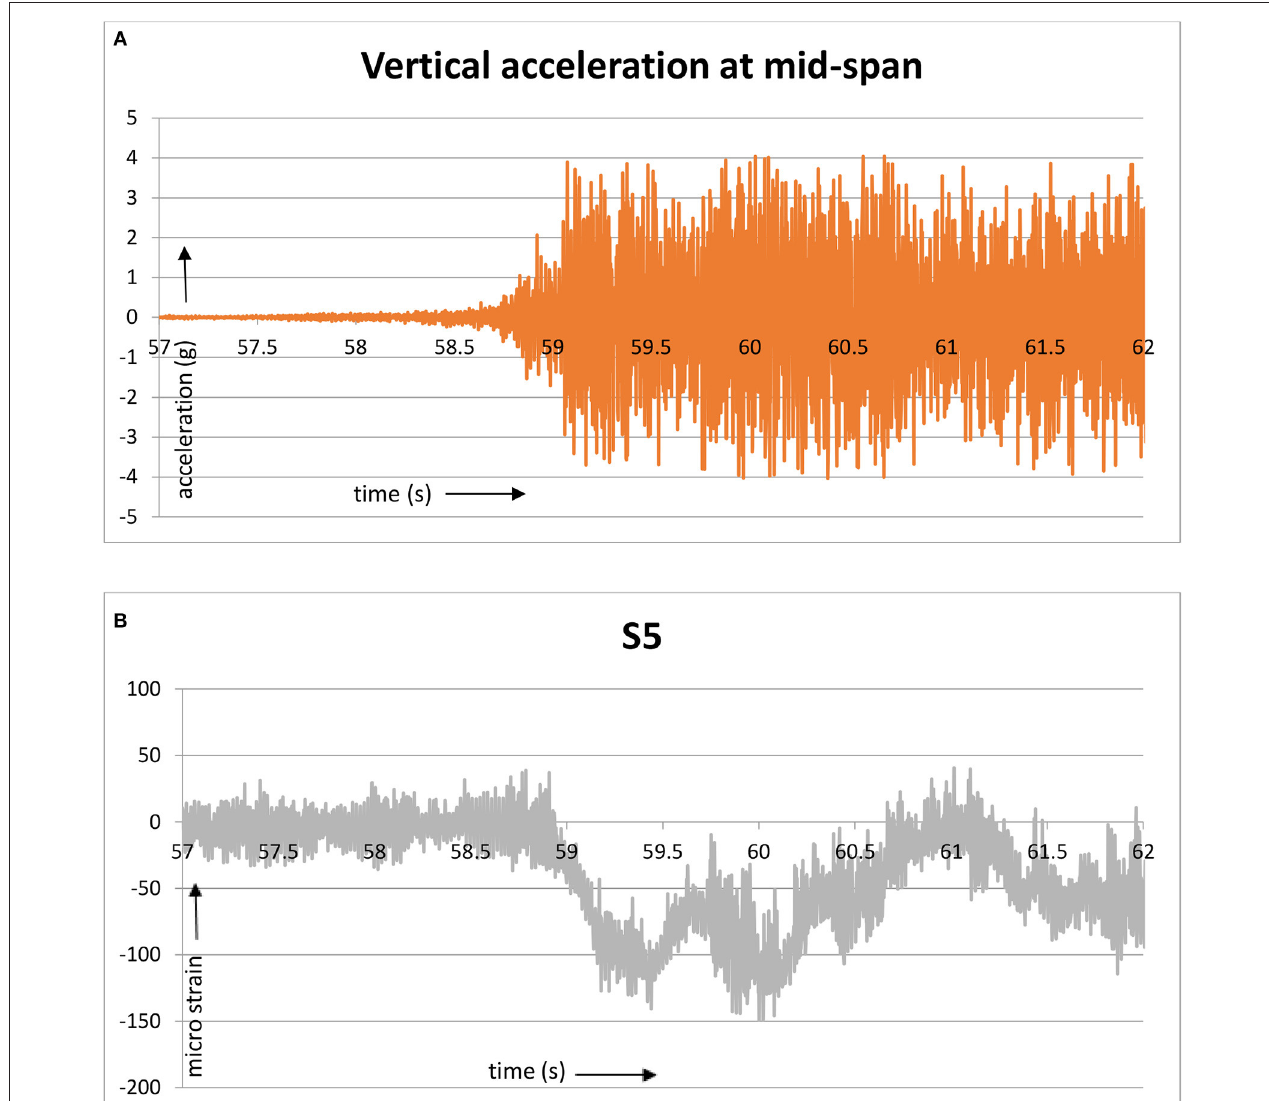
FIGURE 7 | Sensor readings at the mid-span when the train enters the span. (A) Vertical acceleration. (B) Longitudinal strain.